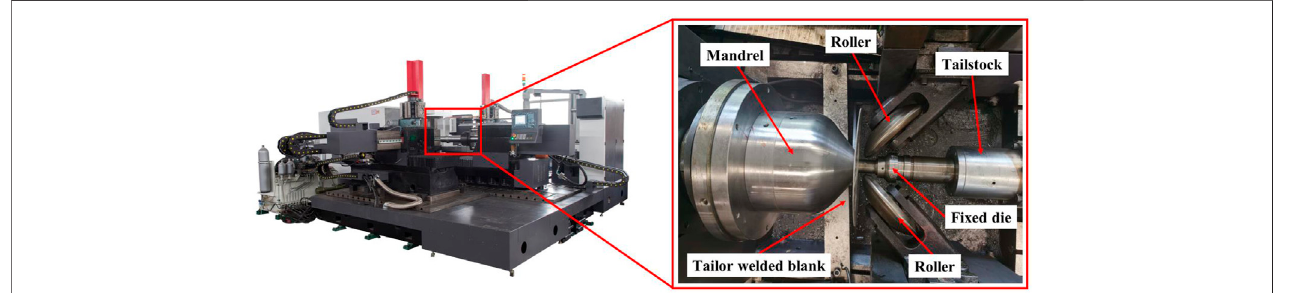
FIGURE 3 | Experimental spin machine and